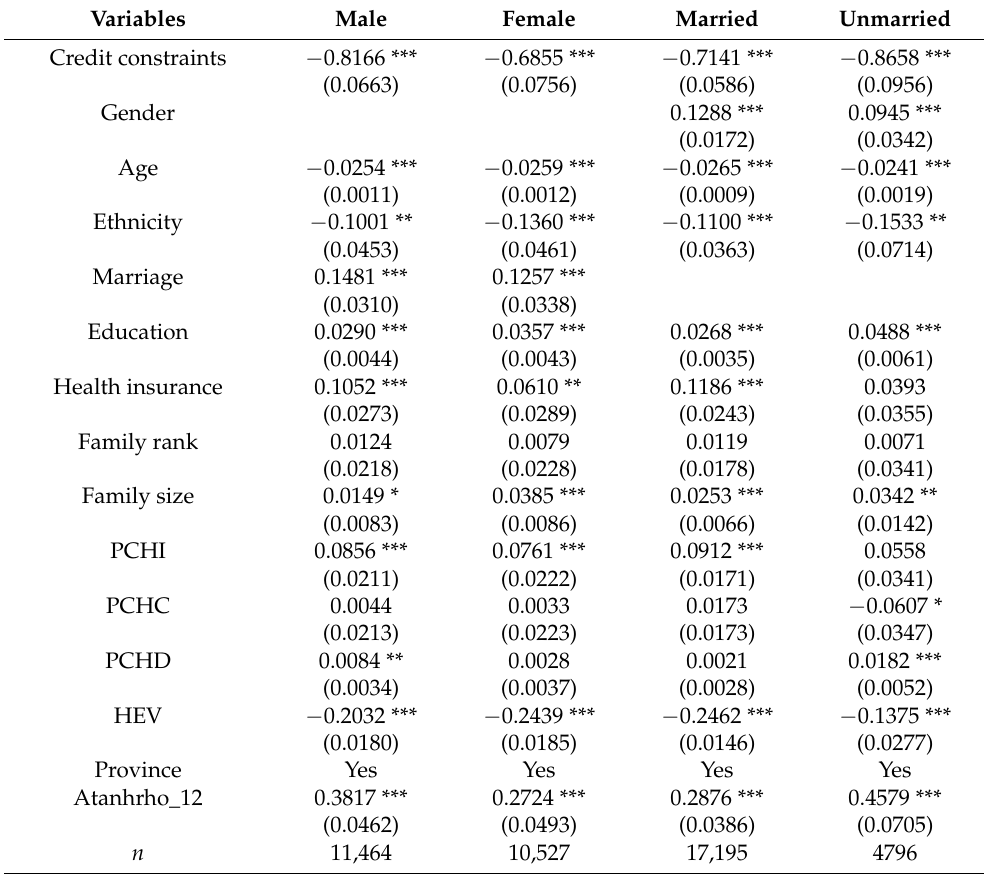
Table 4. Impact of formal credit constraints on rural residents’ self-rated health on different groups as obtained from using IV-ordered probit